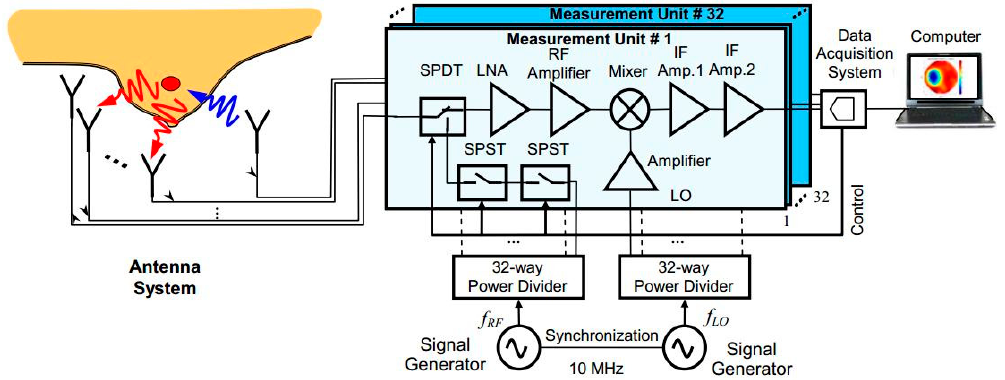
Figure 5. Schematic block diagram of microwave imaging [59].